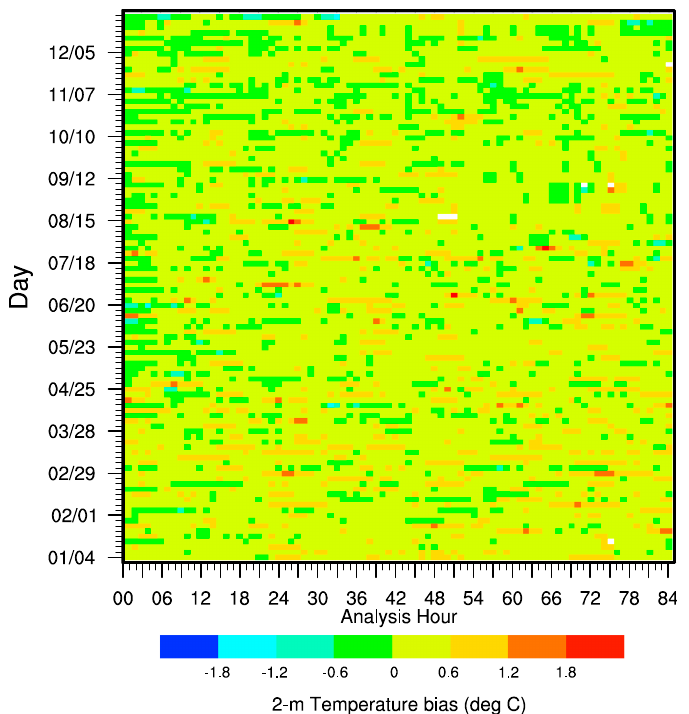
Figure 14. Domain averaged 2-m temperature bias in 2016 for the GFS control member. The empty part (white) corresponds to the missing value.